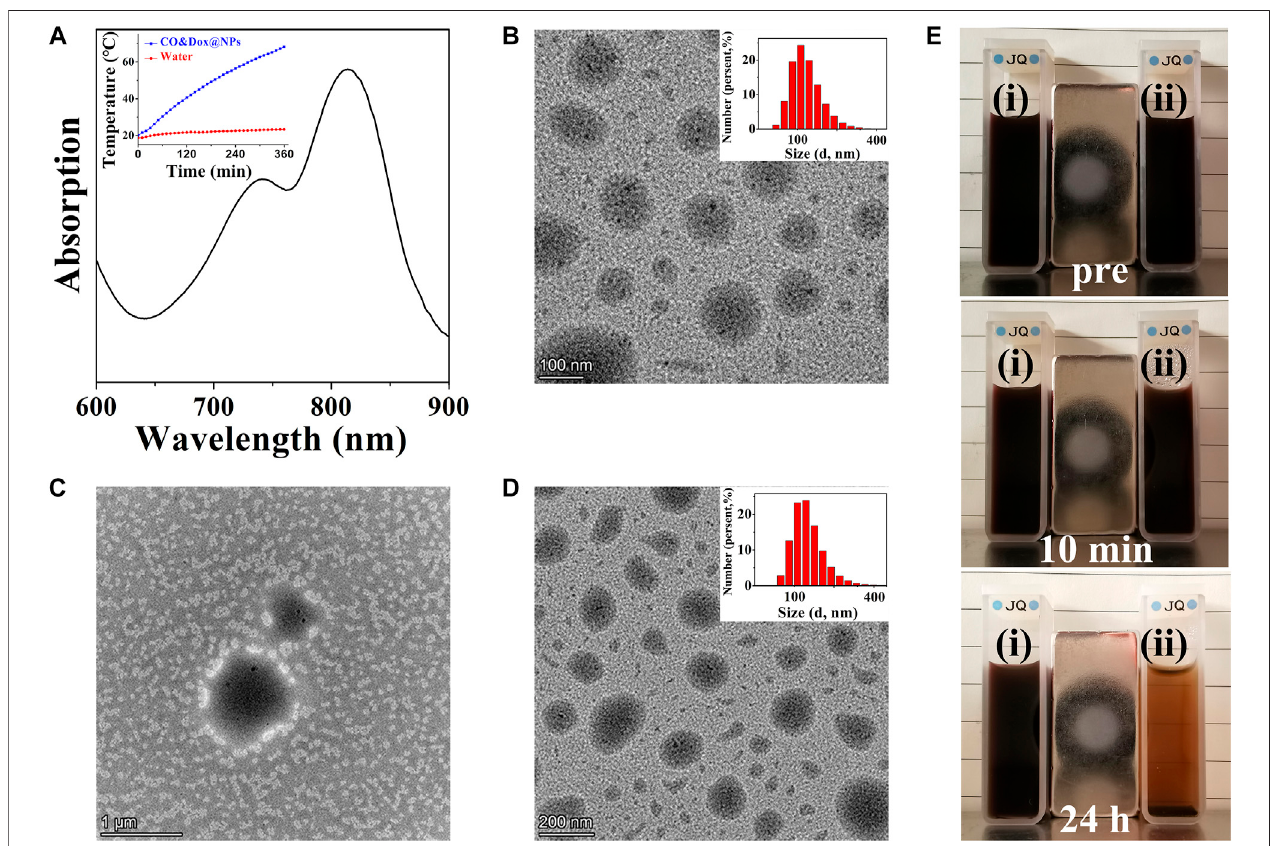
FIGURE 4 | Characterization of nanomedicine (CO&Dox@NPs). (A) UV-vis spectra of CO&Dox@NPs solution (insert: temperature variation pro fi les of the CO&Dox@NPs); (B) TEM image of freshly prepared CO&Dox@NPs (inset: hydrodynamic diameter distribution); (C) TEM image of freshly prepared CO&Dox@NPs after 10 min of irradiation; (D) TEM image of CO&Dox@NPs after 24 h of standing without irradiation (inset: hydrodynamic diameter distribution); (E) Optical camera image of CO&Dox@NPs with (i) and without (ii) NIR irradiation, pre-irradiation (pre), after 10 min of irradiation (10 min), and 24 h post irradiation (24